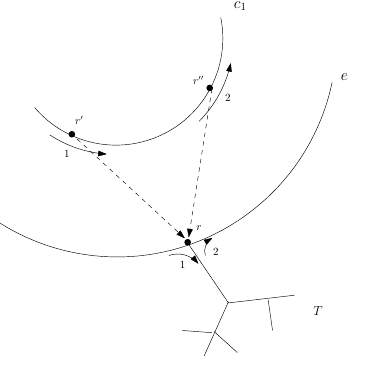
Fig. 5. In the case t ¤